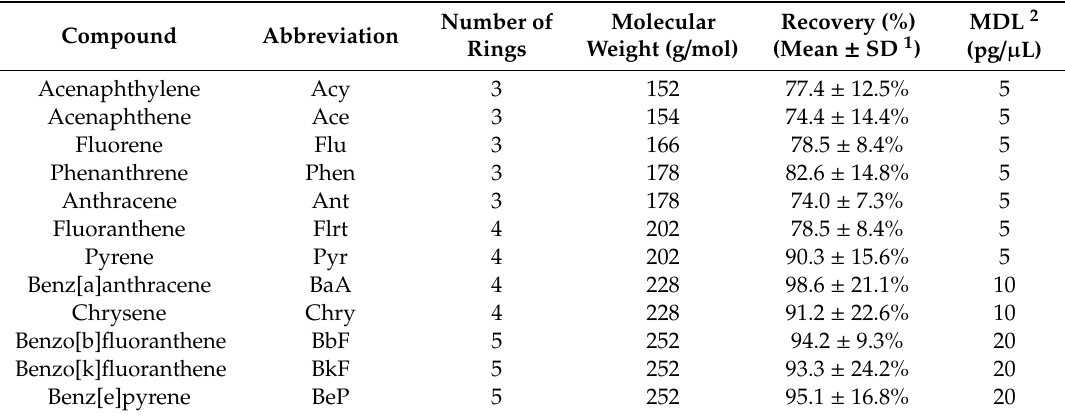
Table 1. Number of rings, molecular weight, recovery rates, and method detection limits for 17